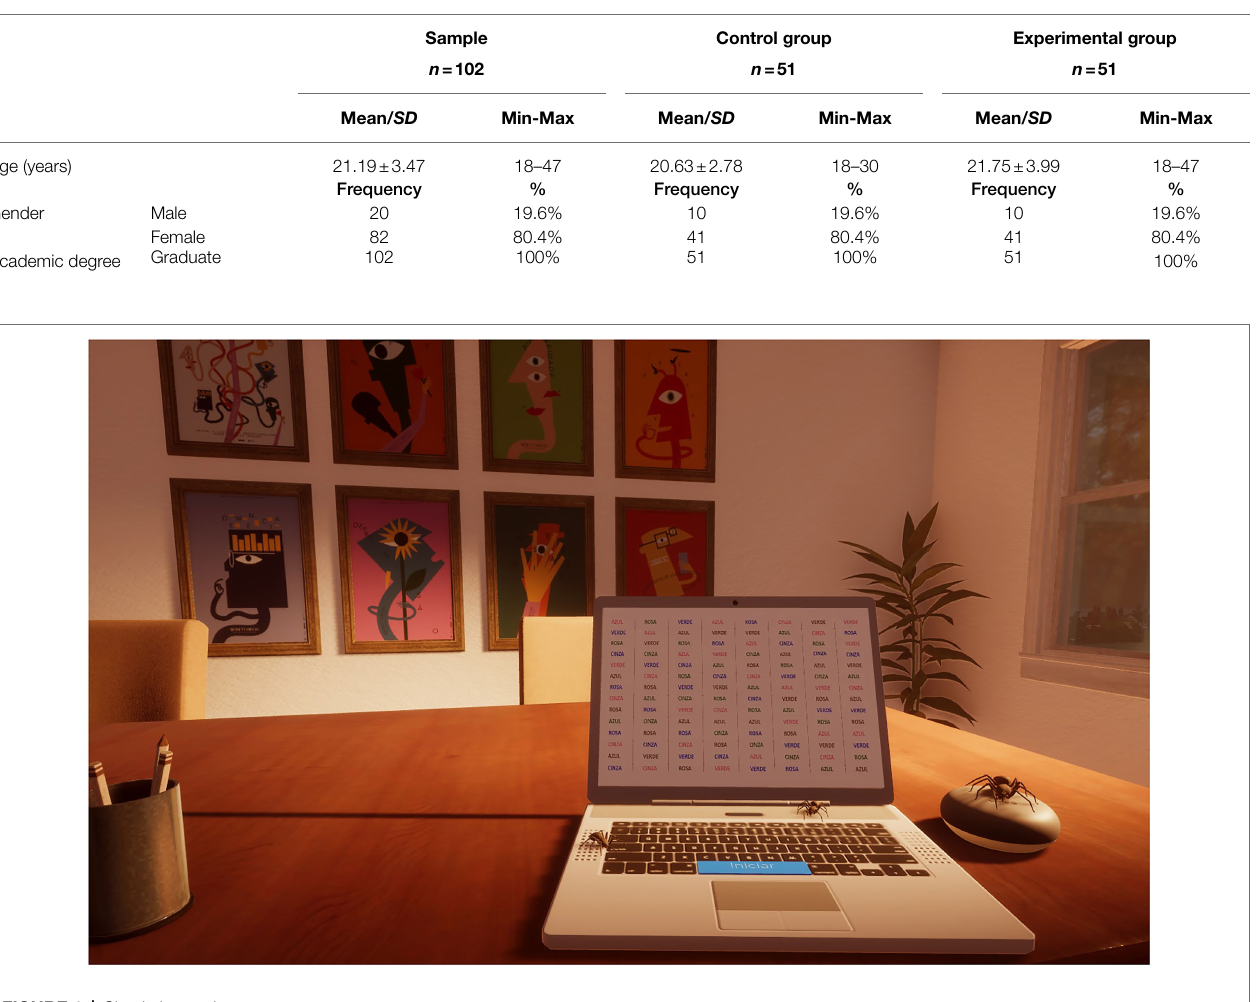
FIGURE 1 | Simulation environment.